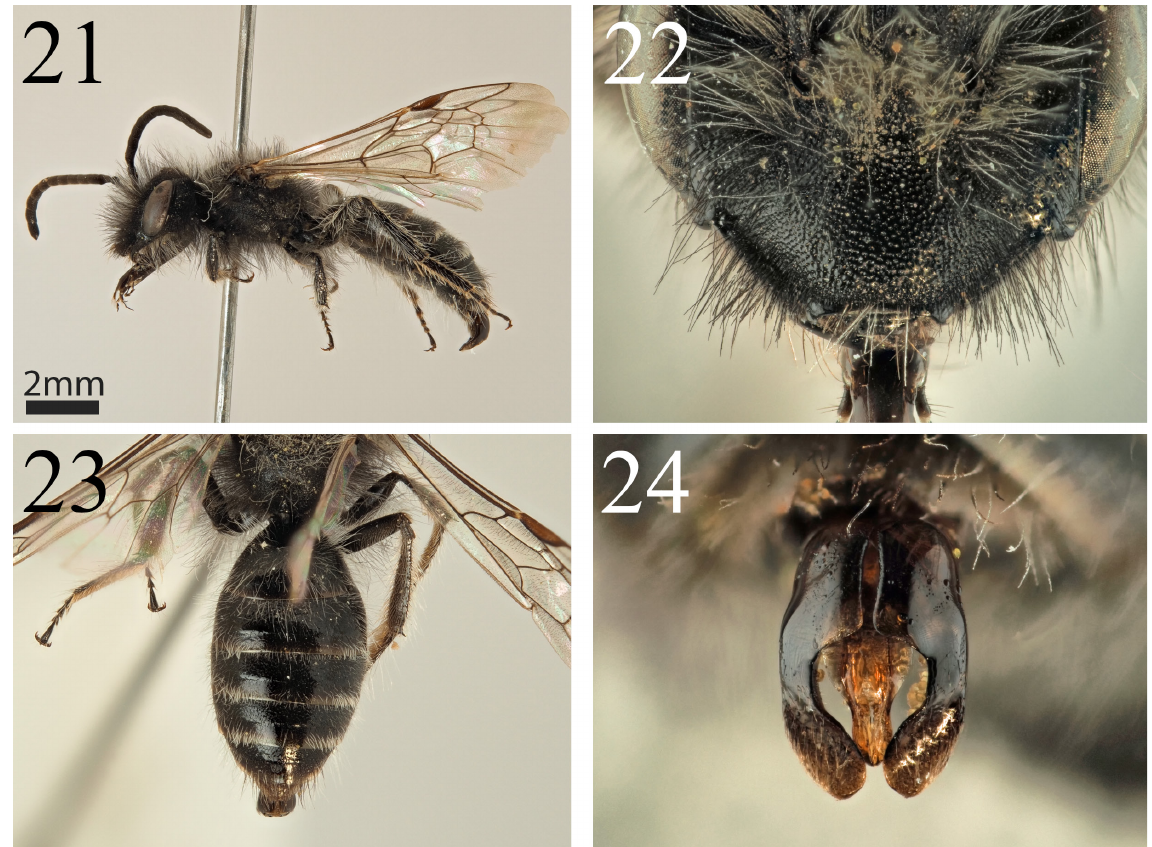
Figs 21–24. Andrena boustaniae Wood sp. nov., ♂ (OÖLM). 21 . Profile. 22 . Face. 23 . Terga. 24 .